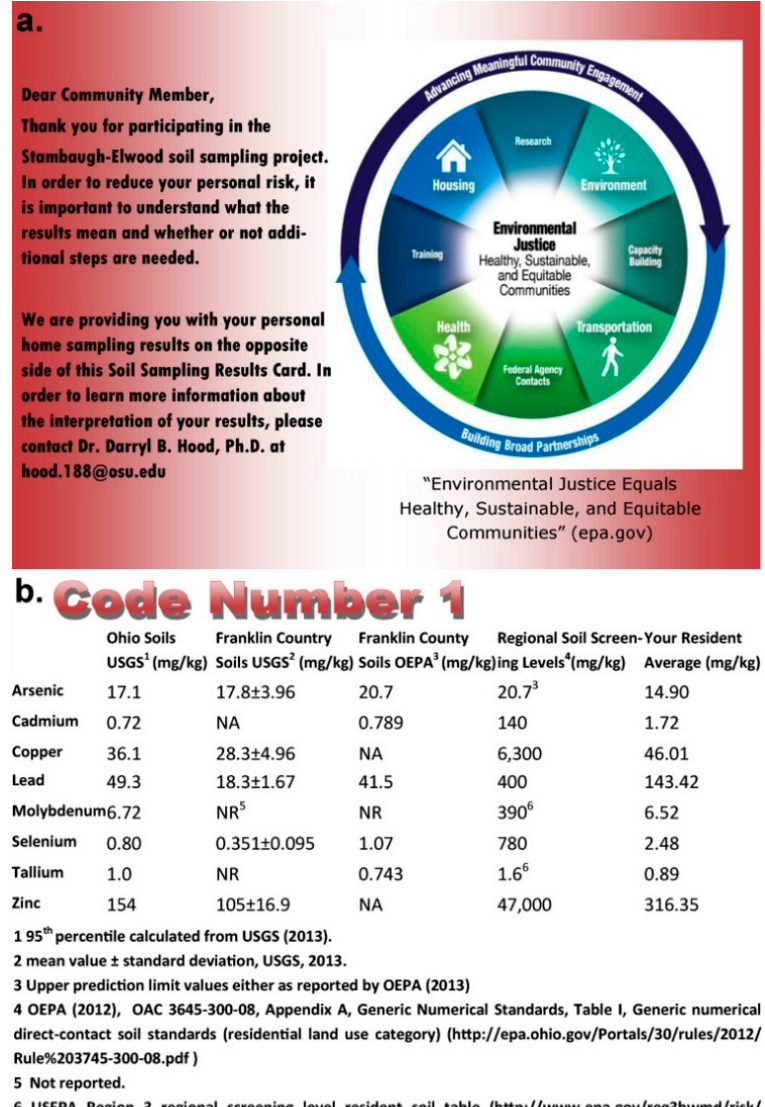
Figure 15. ( a , b ) Informational postcard developed and customized for residents of